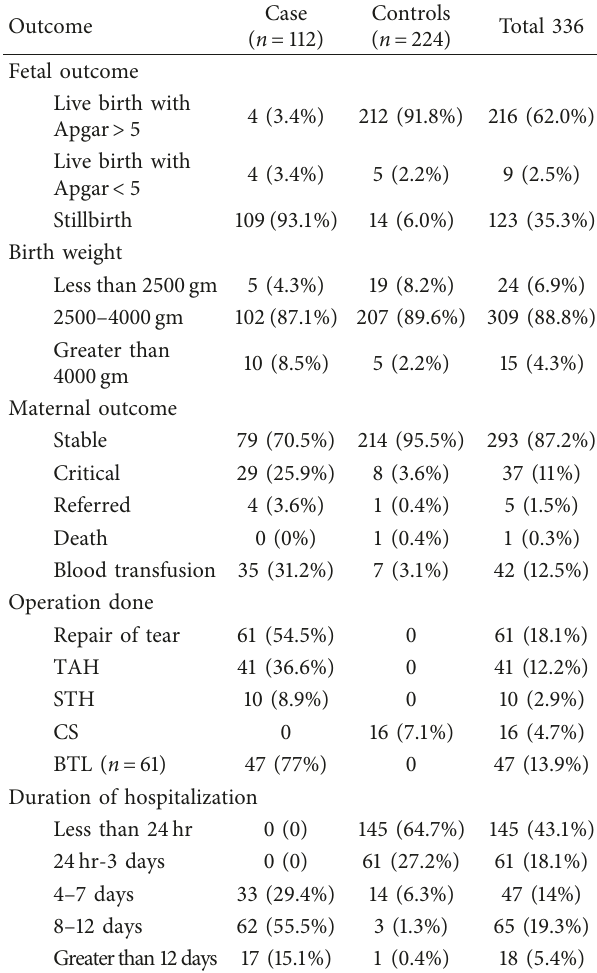
Table 4: Maternal and neonatal outcome of uterine rupture at Suhul General Hospital, Shire Town, North West Tigray, Ethiopia